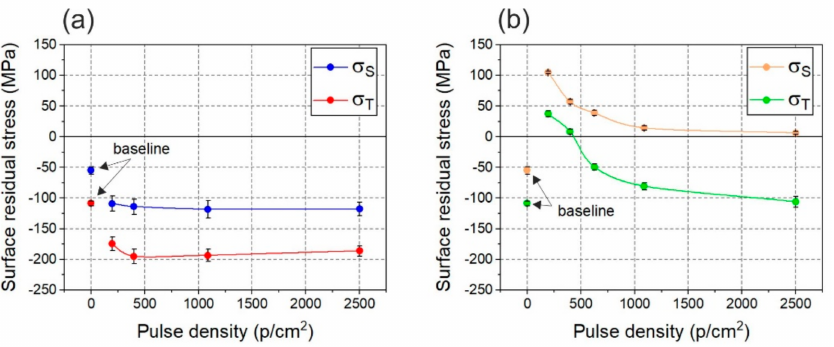
Figure 7. Surface residual stresses in LPwC treatments as a function of laser pulse density: ( a ) LPwC IR and ( b ) LPwC